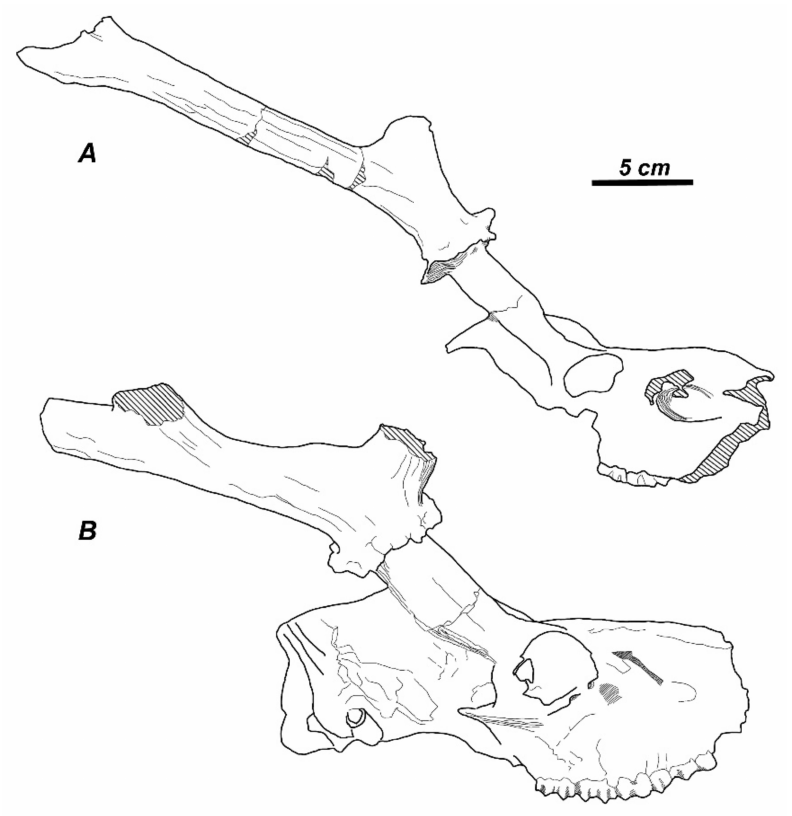
Figure 4. Cranial remains of two cervid forms from the Hipparion fauna of Shansi ascribed by Zdansky [46] to “ Cervoceros novorossiae ”: ( A ), a small deer with slender antlers, convex frontals and parietals; ( B ), a large deer with flattened parietals and frontals, and robust antlers. Adapted from Zdansky